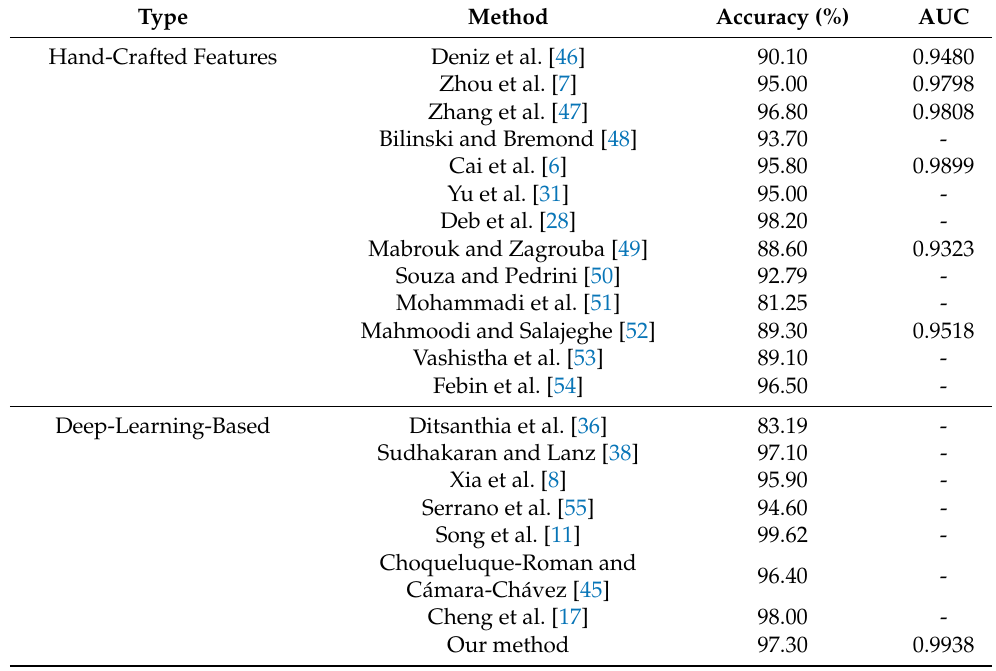
Table 2. Comparison of the proposed method and other previous methods on the Hockey Fight dataset.